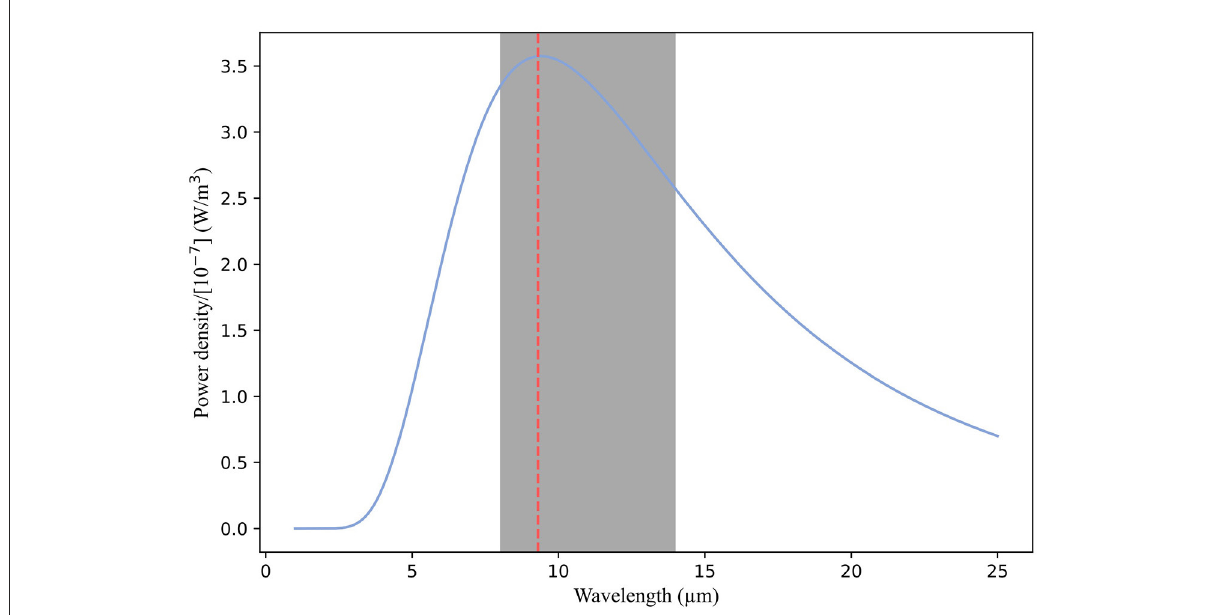
FIGURE7 Graph showing the blackbody spectrum for a body at 308.15K (35 ◦ C). For organic tissue at this temperature, thermal energy intensity peaks around 9.3 µ m. Cameras with a spectral range including this peak with a wavelength range of 8–14 µ m are likely to estimate the apparent temperature well. Cameras covering a more limited wavelength range, such as 3–5 µ m, will have to extrapolate to find this peak, leading to greater uncertainty in the final